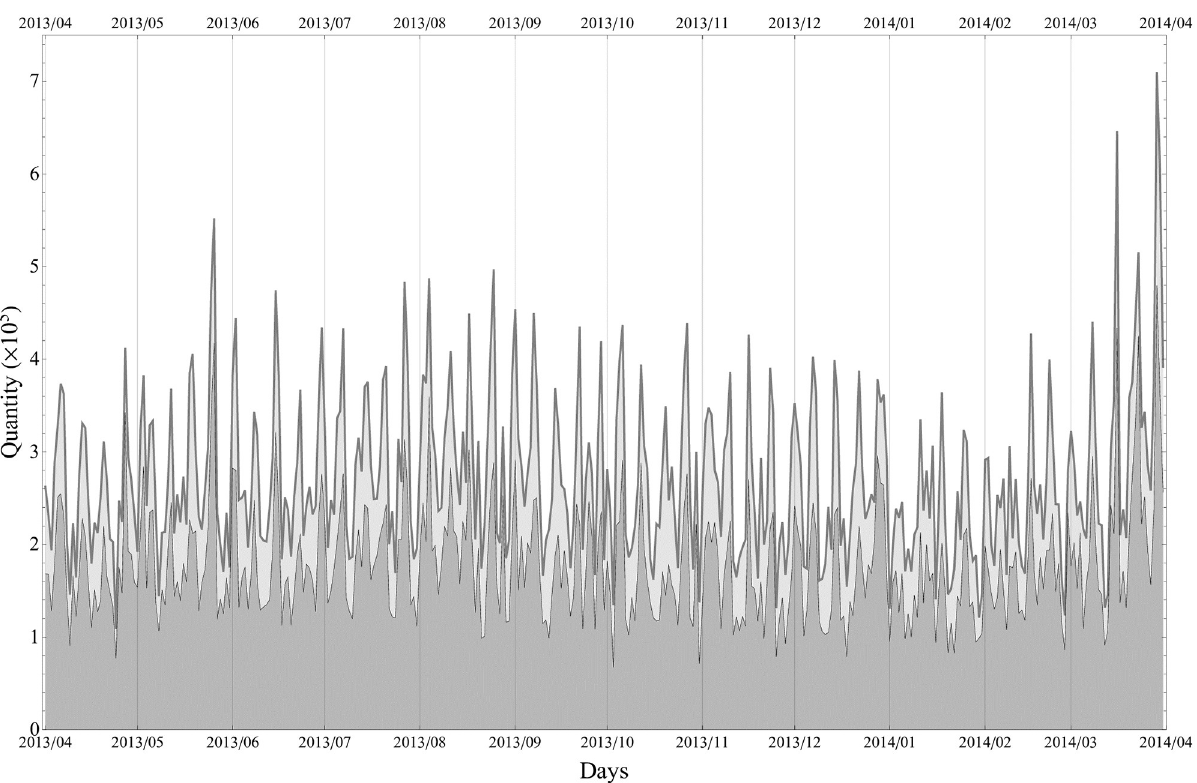
Fig 2. Daily total quantities. Light gray: all products, Dark gray: Selected 18 products. Apparent periodic peaks correspond to Sundays.